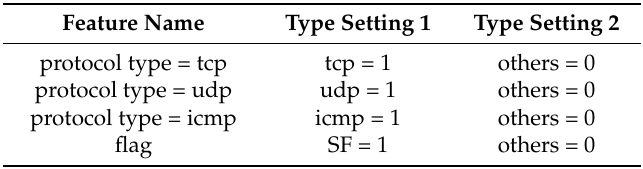
Table 3. The nonnumeric feature conversion in the KDD Cup 99 data.